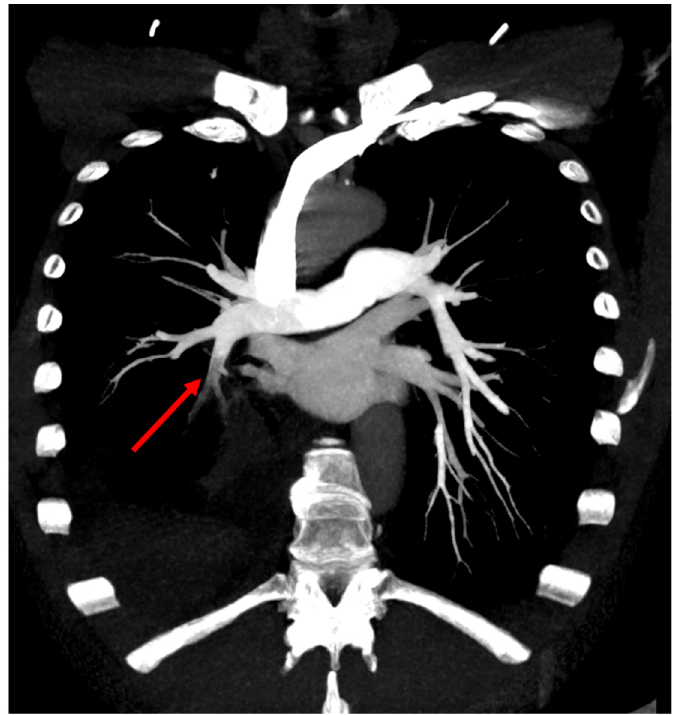
Figure 3. Maximum intensity projection reformat of CTPA showing a segmental filling defect in a segmental artery of the right lower lobe.